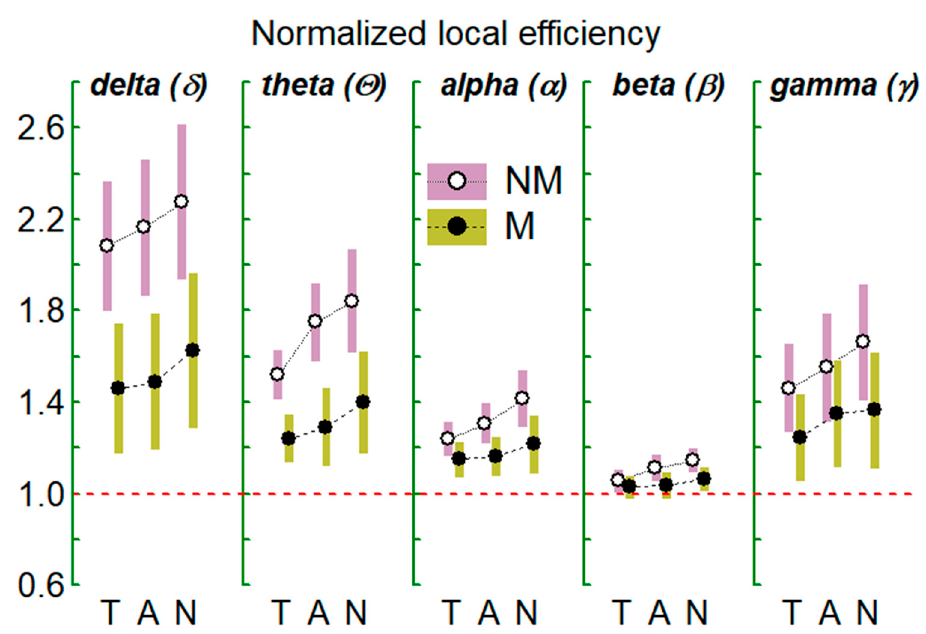
Figure 7. As in Figure 5 but for the normalized local efficiency of the EEG graph/network. The red line indicates the limit value for a random network according to the selected normalization process.